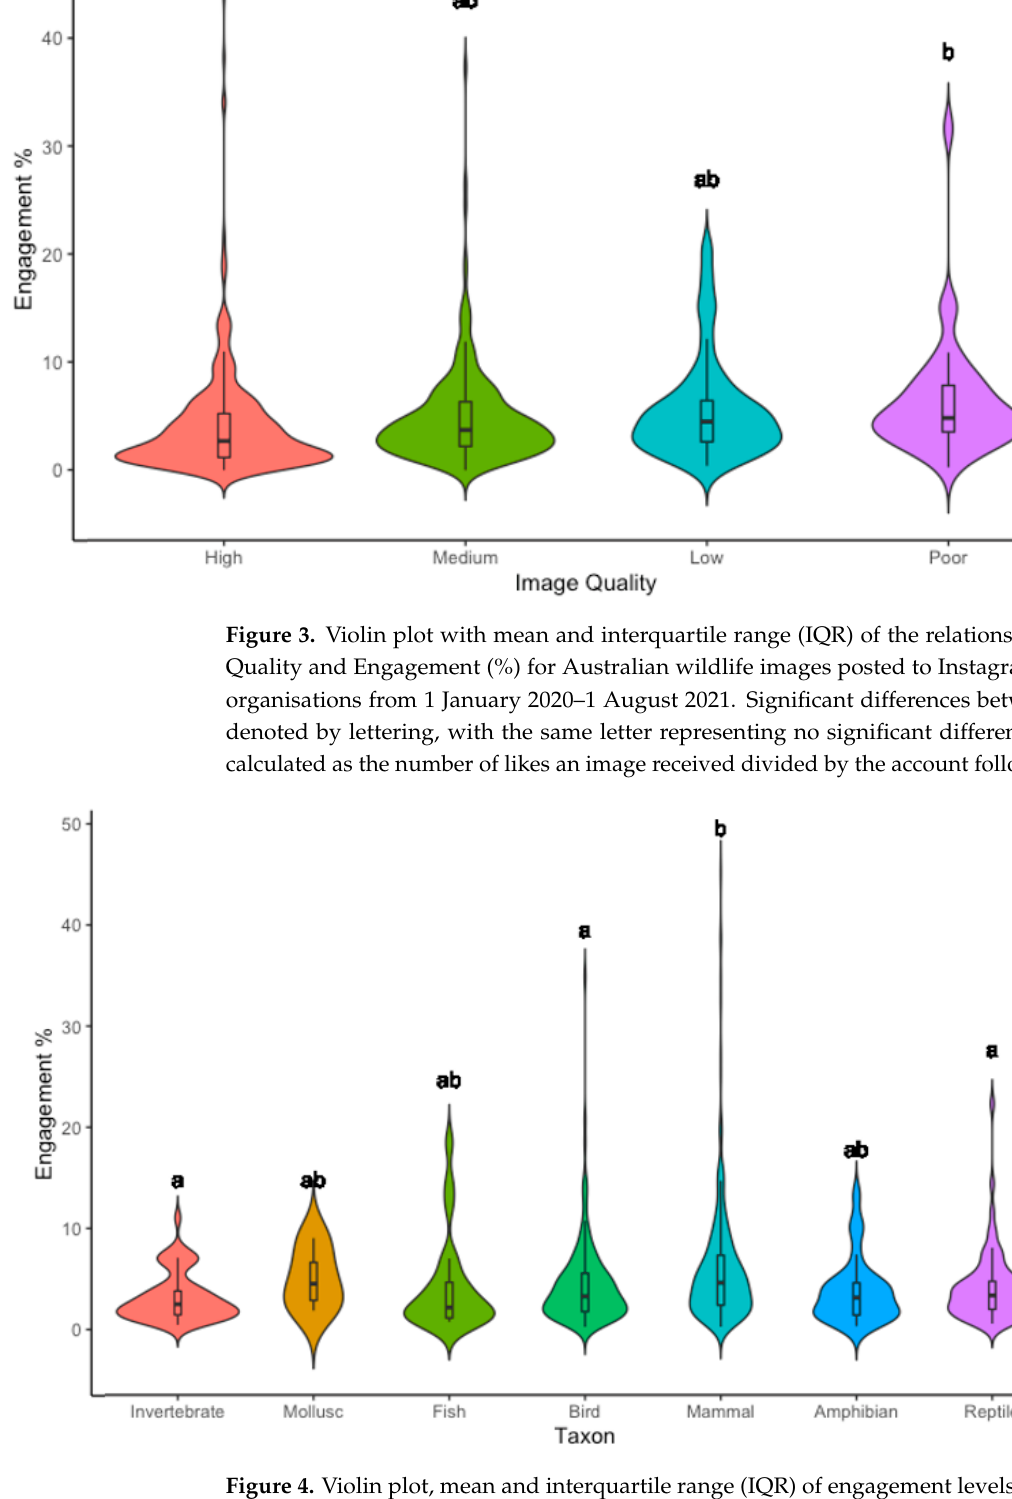
Figure 4. Violin plot, mean and interquartile range (IQR) of engagement levels (%) for each Taxon shown in Australian wildlife images posted to Instagram by conservation organisations from 1 January 2020–1 August 2021. Significant differences between categories are denoted by lettering, with the same letter representing no significant difference. Engagement is calculated as the number of likes an image received divided by the account follower count.